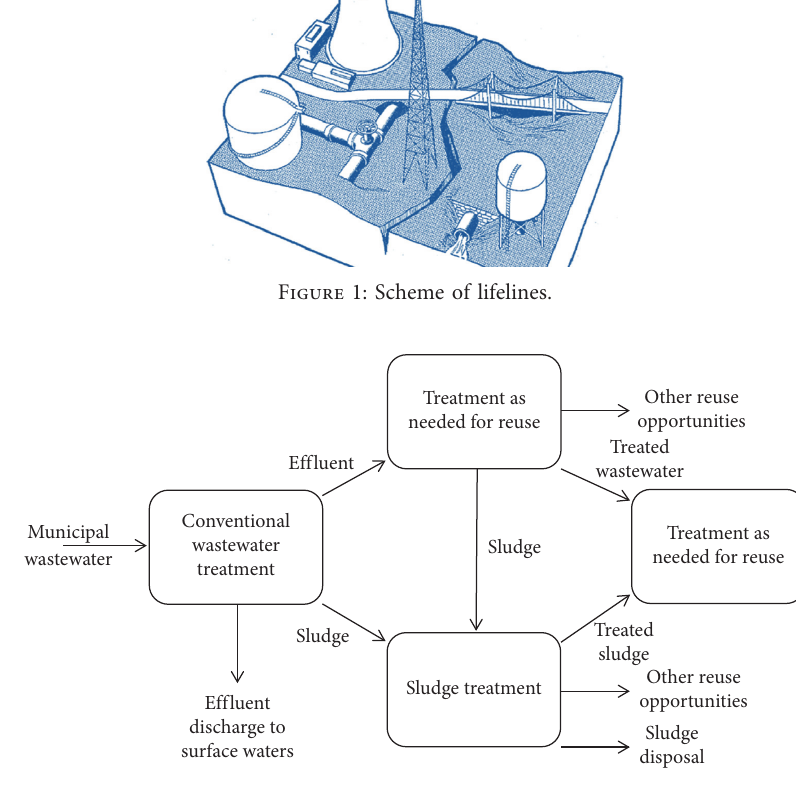
Figure 2: The scheme of a sewage system.